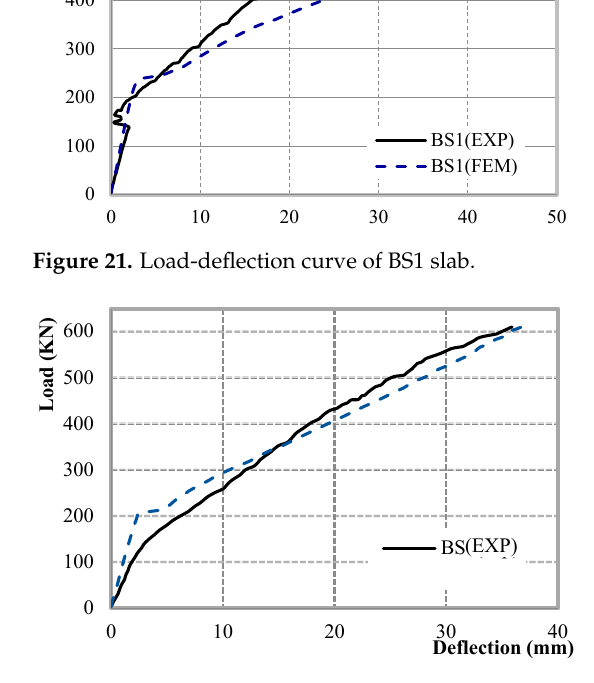
Figure 23. Load-deflection curve of US slab.